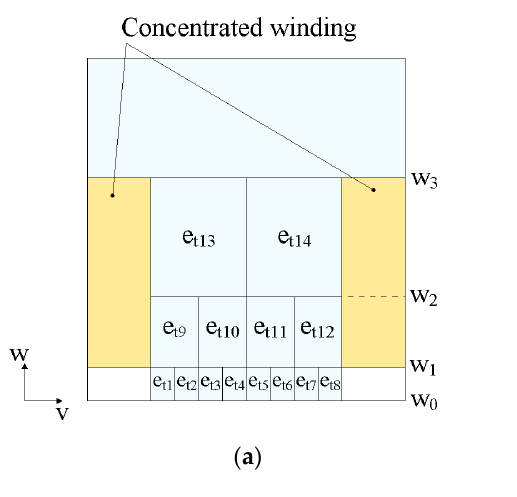
Figure 27. Open-circuit line-to-line EMF per-turn for I exc = 0 A.